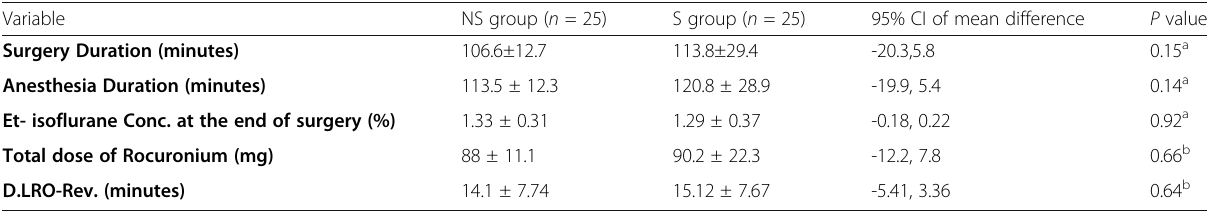
Data are expressed as mean and standard deviation. 95% CI: 95% confidence interval. a Mann Whitney independent samples test, b Independent samples t-test. * p is significant when ˂ 0.05. Abbreviations : Et End tidal, Conc. Concentration, D.LRO-Rev. Duration between last dose rocuronium and reverse, group (NS) half dose sugammadex plus neostigmine, group (S) full dose sugammadex